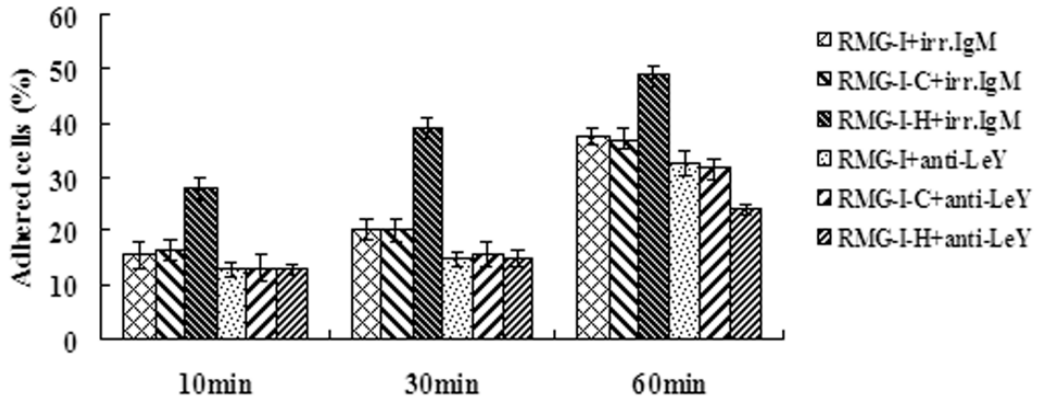
Figure 4. Changes in cell adhesion after anti-LeY mAb/irrelevant IgM antibody treatment. Data are means ± SE from three individual